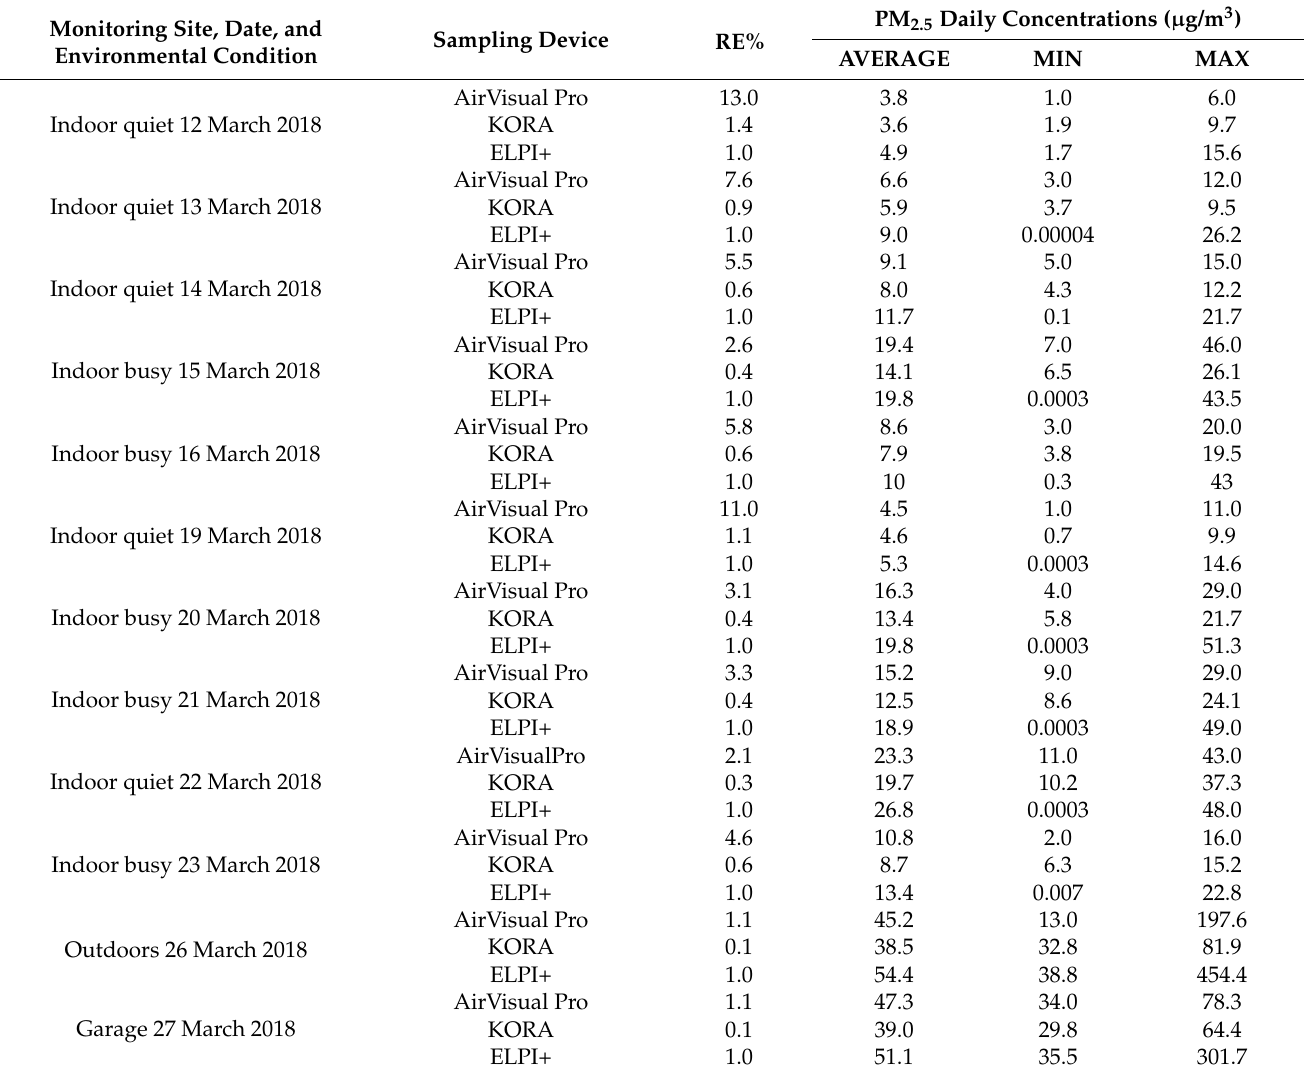
Table 3. PM 2.5 daily minimum, maximum, and average concentrations measured by real-time sampling devices. Minimum and maximum concentrations, and the relative percent error (RE%) are also